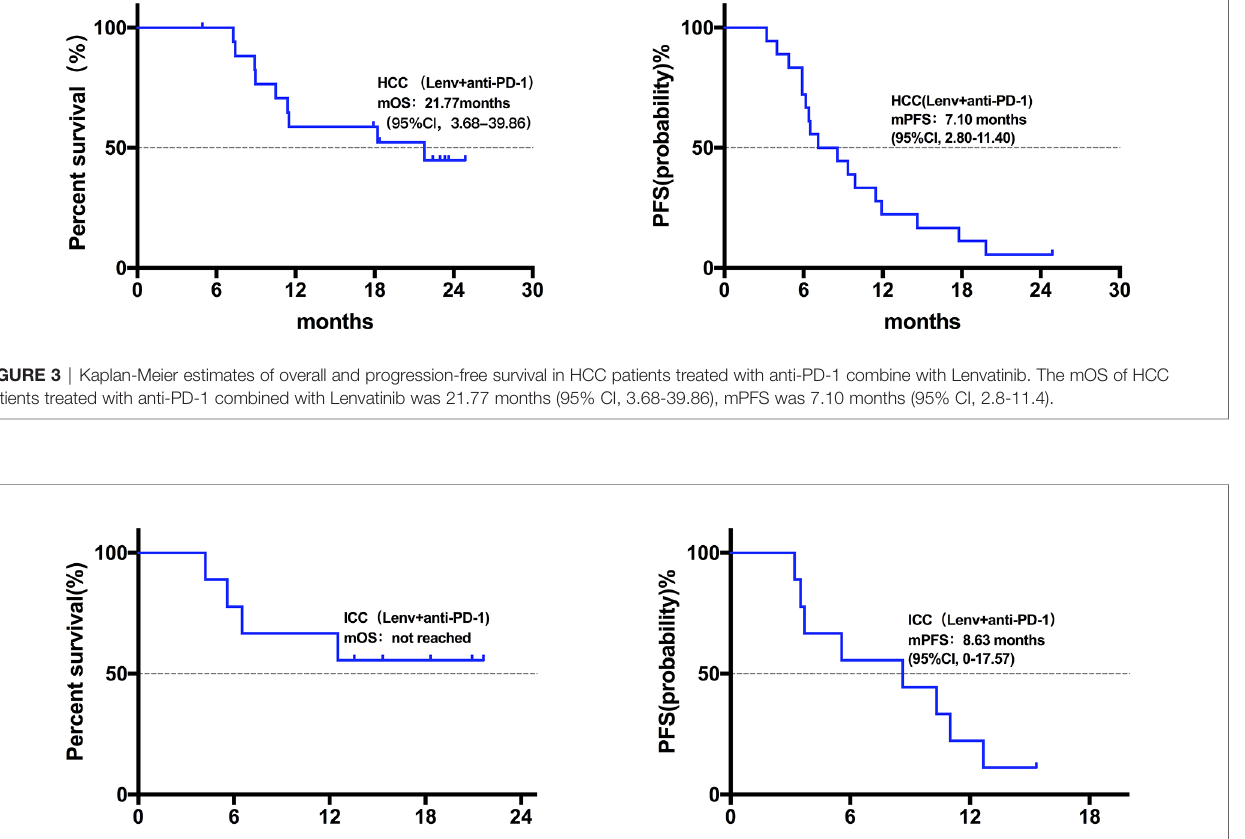
FIGURE 4 | Kaplan-Meier estimates of overall and progression-free survival in ICC patients treated with anti-PD-1 combine with Lenvatinib. The ICC patients did not reach mOS; mPFS was 8.63 months (95% CI,